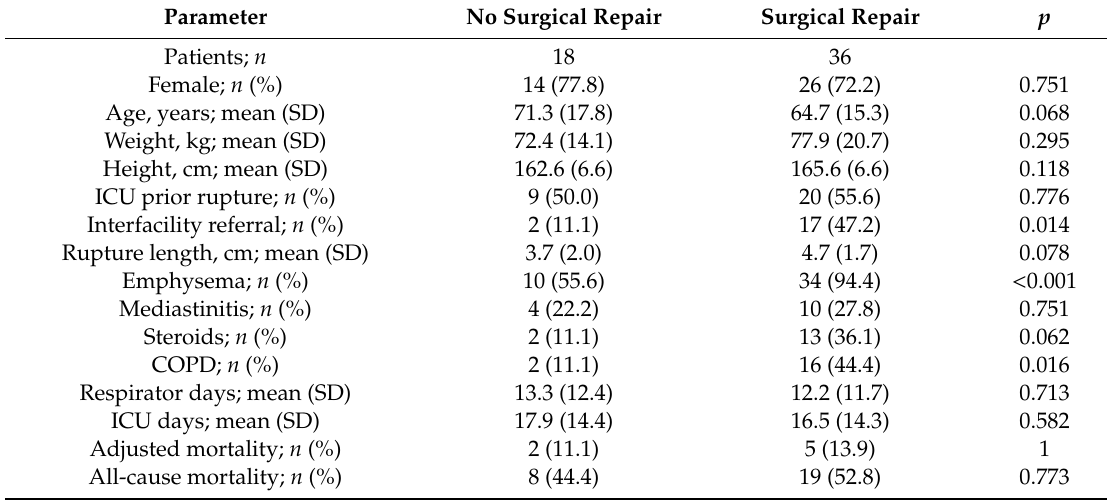
Table 2. Comparison of characteristics between patients with and without surgical